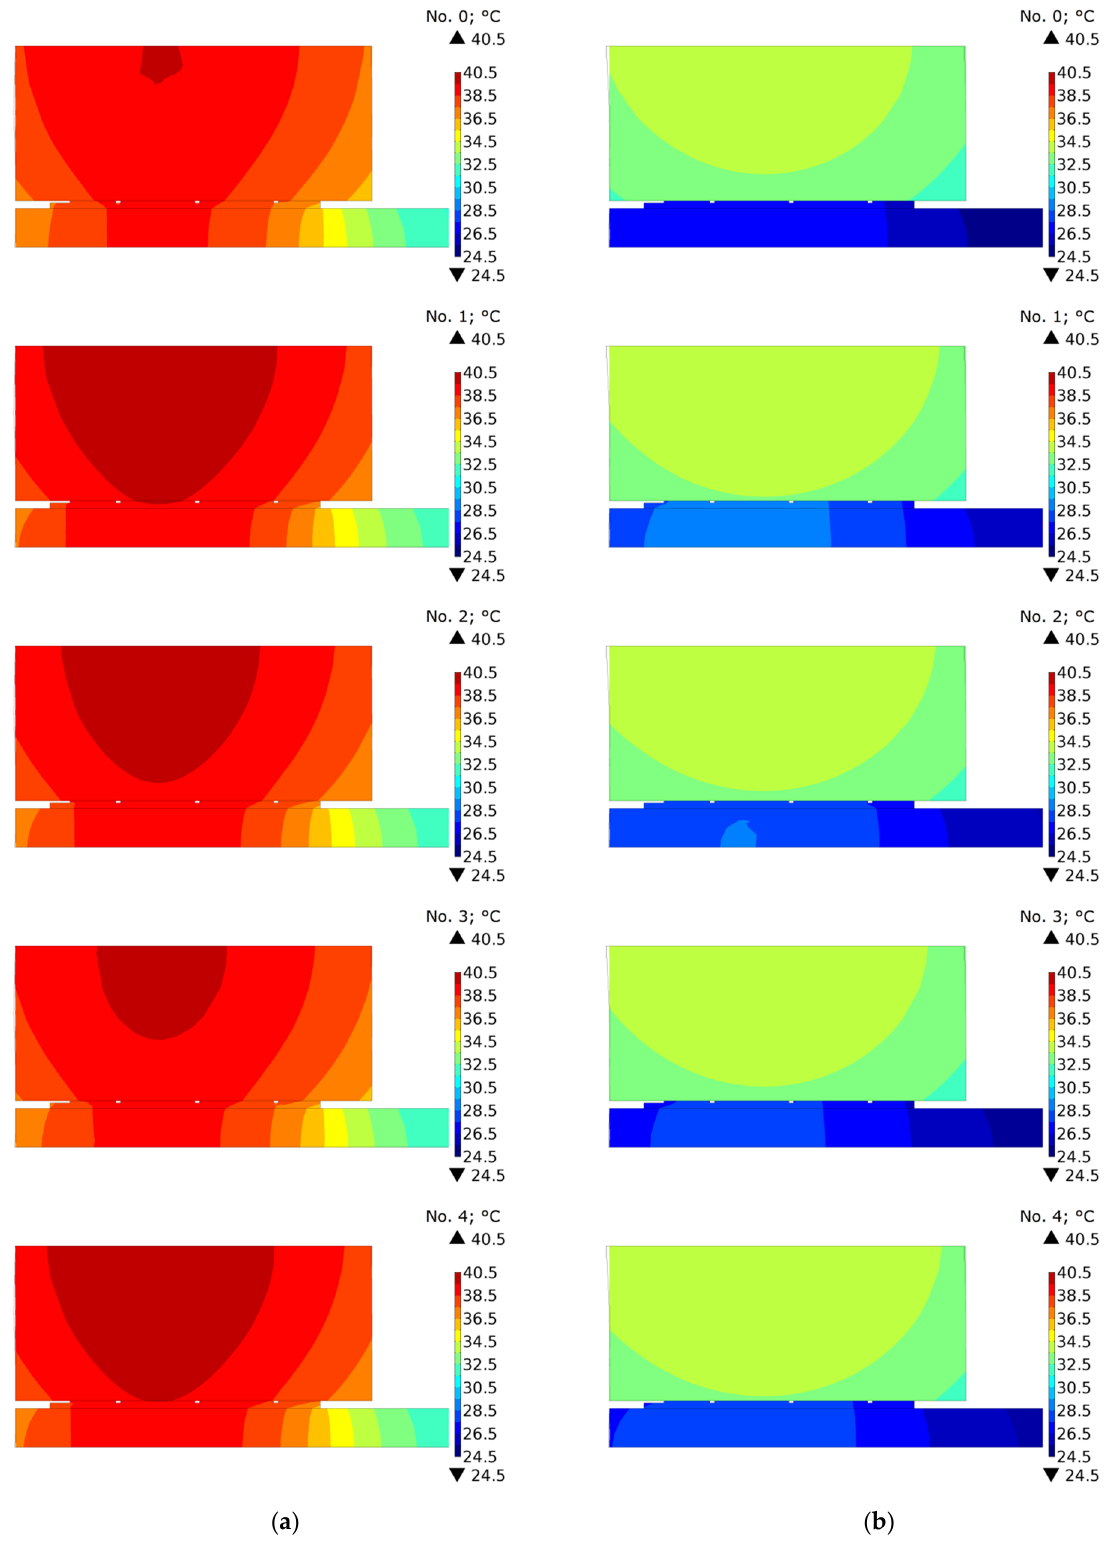
Figure 10. Temperature distribution at time t s + 55 s obtained using: ( a ) connected [6]; and ( b ) disconnected parts of the clutch for materials no. 0, 1, 2, 3,